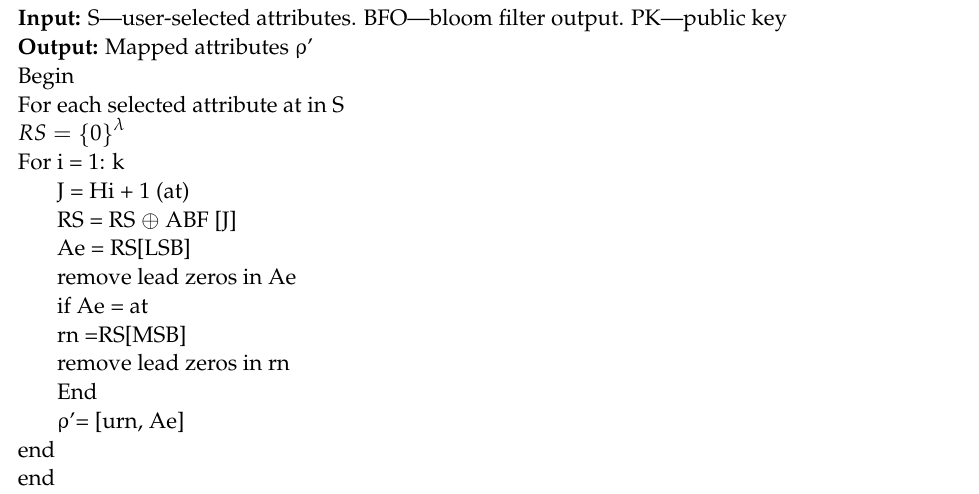
Algorithm 3 : Attribute Extraction Using BF